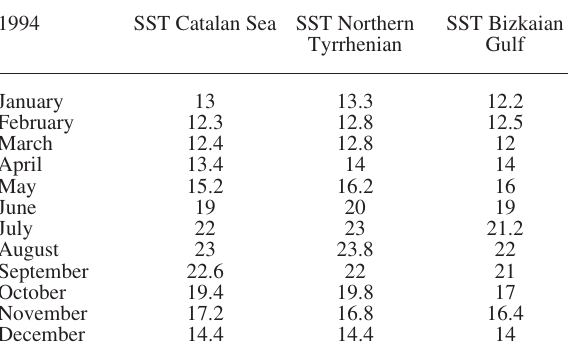
Table 6. – 1994 mean monthly sea surface temperature (SST) (ºC) series data in the northern Atlantic and western Mediterranean ar- eas. Data obtained from Levitus and Boyer